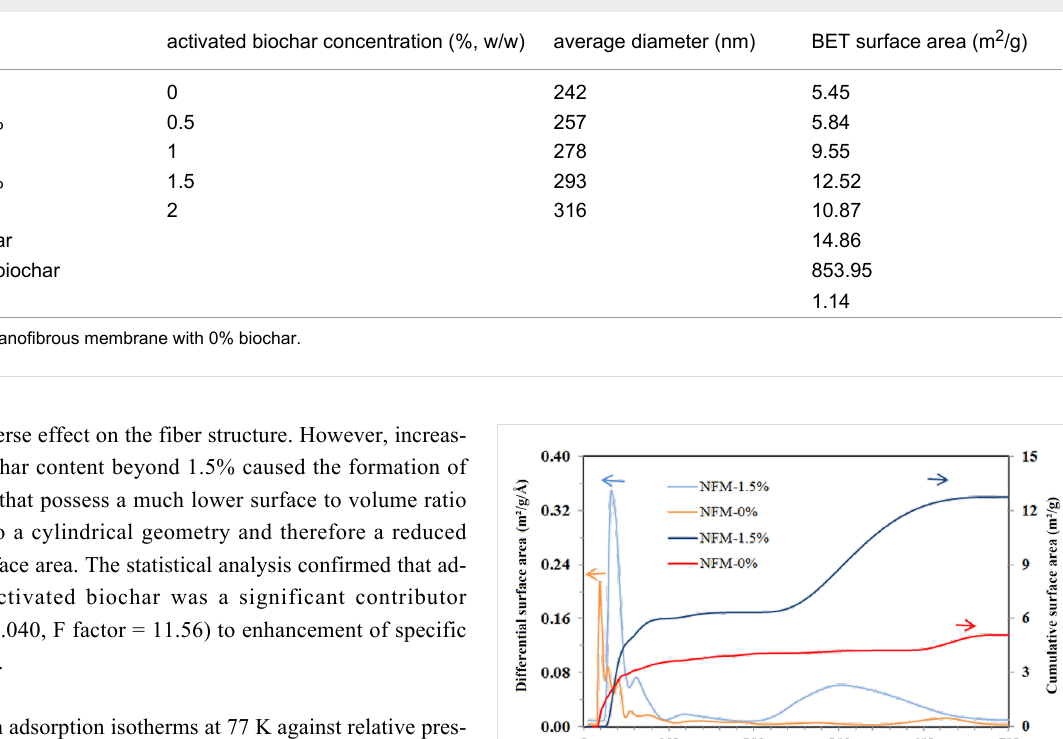
Table 1: Average diameter and BET surface area of fabricated nanofibrous membranes. a